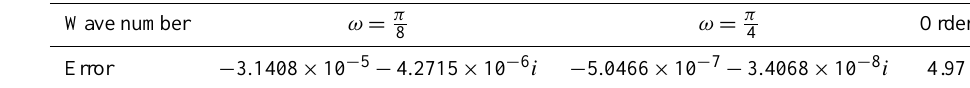
Table 1. Numerical errors at two wave numbers and corresponding convergence rate.